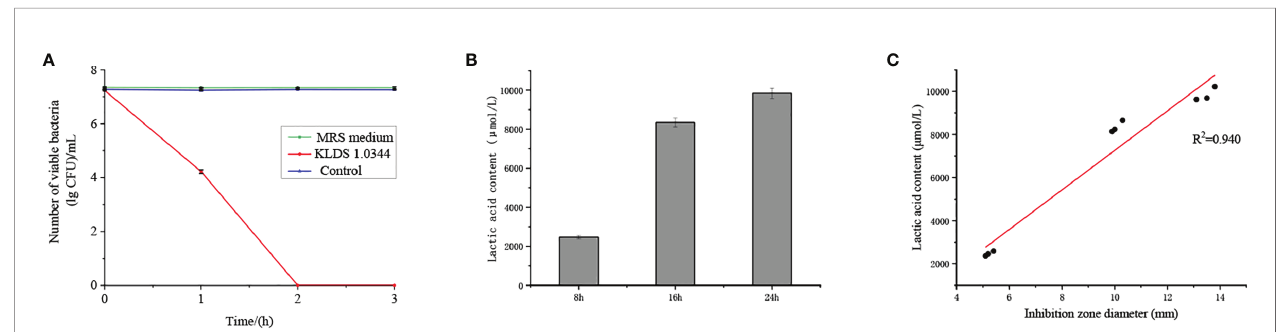
FIGURE 1 | (A) . The bactericidal effect of CFS on Escherichia coli ATCC25922 was quanti fi ed by the lgCFU value of the number of viable bacteria. The control group was treated with saline, and the MRS medium without bacteria was adjusted to pH = 4. (B) The contact dependence inhibition effect was expressed by the number of viable bacteria under the co-cultivation of Escherichia coli ATCC25922 and L. plantarum KLDS 1.0344, and the control group is Escherichia coli ATCC25922 cultured alone. (C) Lactic acid content in the cell-free fermentation supernatant at different fermentation times. (D) Linear analysis of lactic acid content and bacteriostatic circle diameter. The values obtained for all tests are the mean ± SD (n = 3 independent experiments).